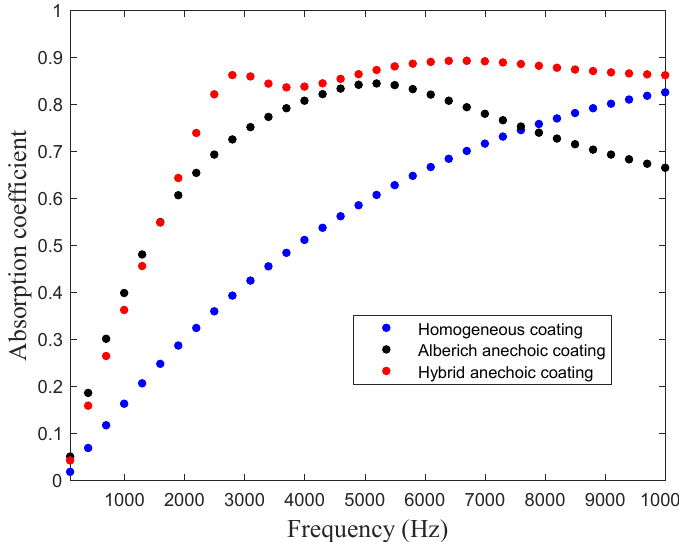
Figure 7. Influence of metastructure without MPP on sound absorption.